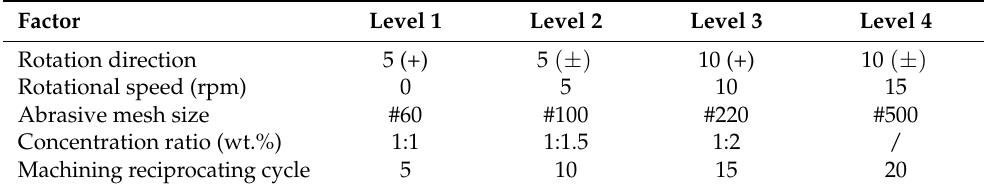
Table 2. The design parameters and the setting levels of the controllable factors.